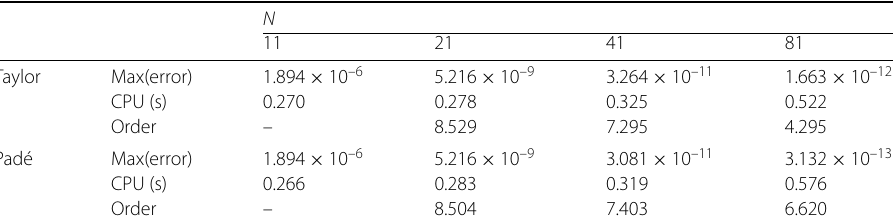
Table 5 Numerical results of one-dimensional parabolic problem with variable coefficients at t = 0.1 for Example 2 N